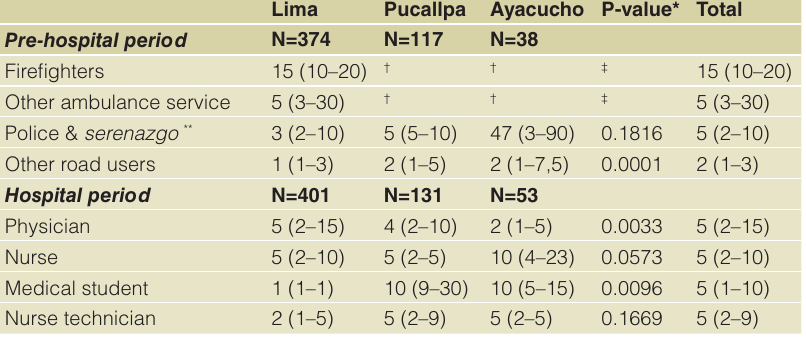
Table 2. Median time (minutes) and interquartile range (IQR) to obtain initial care by provider type in each city within the pre-hospital and hospital